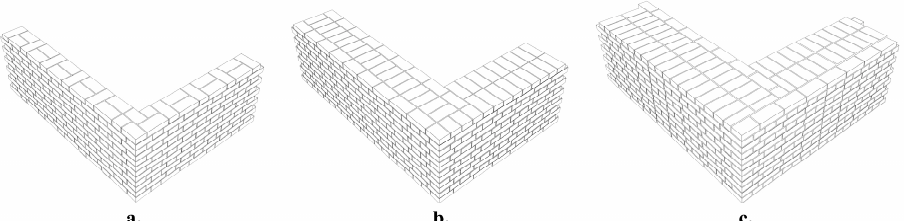
Figure 11. Typical traditional Chinese brick wall ( a ); English bond brick wall ( b ); the brick wall of the LMF ( c ). Pictures by X.X. the LMF ( c ). Pictures by X.X.